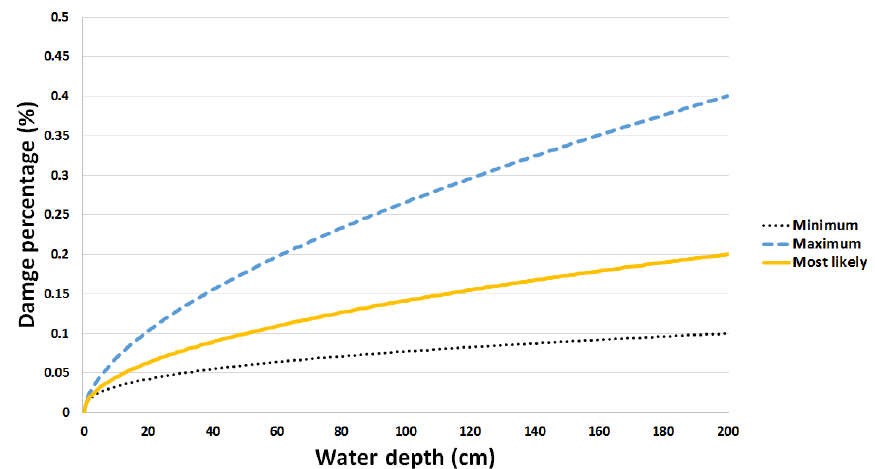
Figure 4. Visualization of minimum, most likely, and maximum damage functions, calculated by bootstrap and chi-square test of goodness of fit.